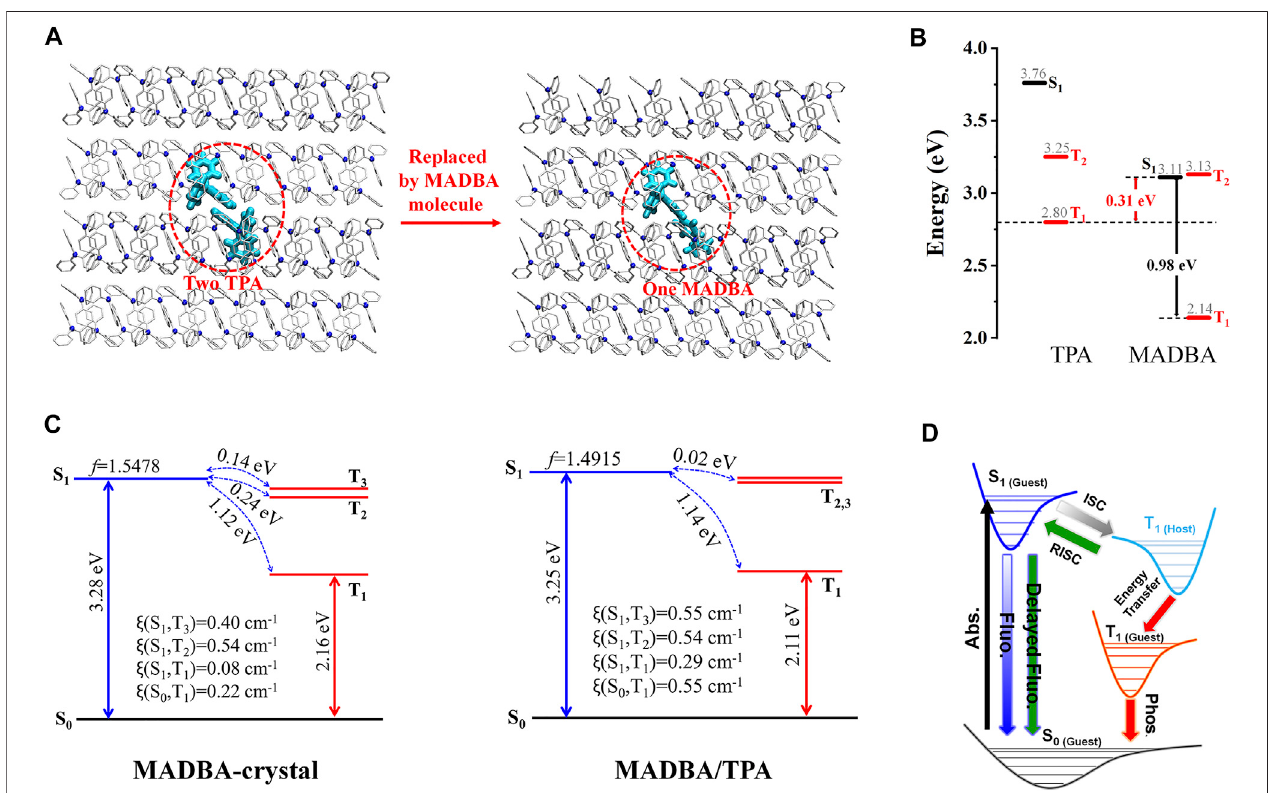
FIGURE 7 | (A) Model setup of the doped system. (B) The energy levels of the host TPA and guest MADBA. (C) The calculated energy level diagram, spin-orbit couplings ( ξ ), and the oscillator strengths for MADBA crystal and the doped system. (D) Proposed transfer pathway between the guest and host after doping. (Reproduced with permission from Lei et al. (2021) Copyright 2021 The Royal Society of